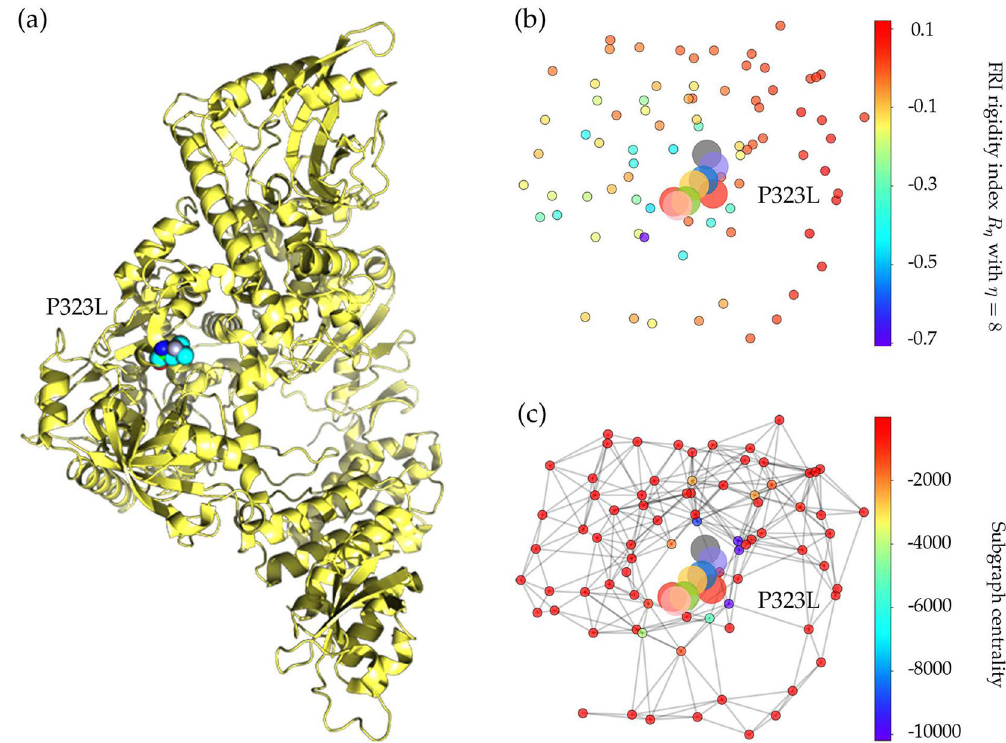
Fig. 3 The 3D structure and network analysis of SARS-CoV-2 NSP12 protein. a The 3D structure of SARS-CoV-2 NSP12 protein. The mutated residue is marked with color balls. b The differences of FRI rigidity index between the network with wild type and the network with mutant type. c The difference of the subgraph centrality between the network with wild type and the network with mutant